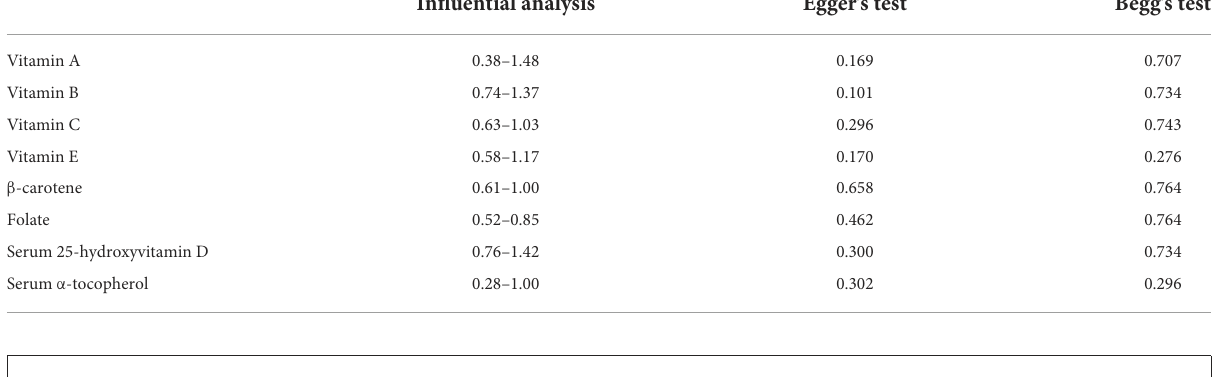
TABLE 4 Sensitivity analysis and publication bias.